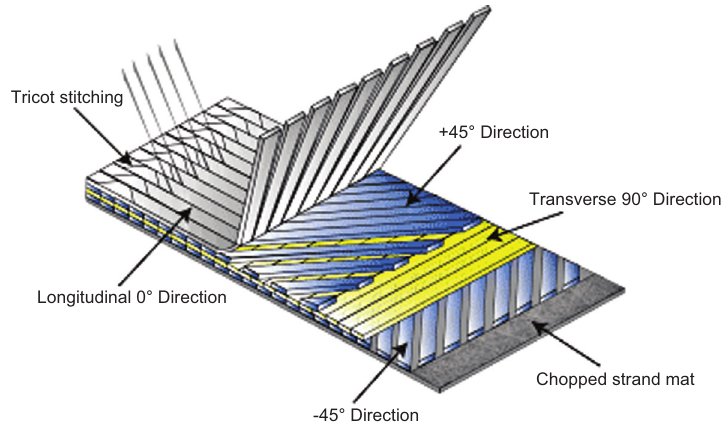
Figure 1 Typical quadraxial ply stack includes 0 ° , 90 ° , +45 ° , and -45 ° plies